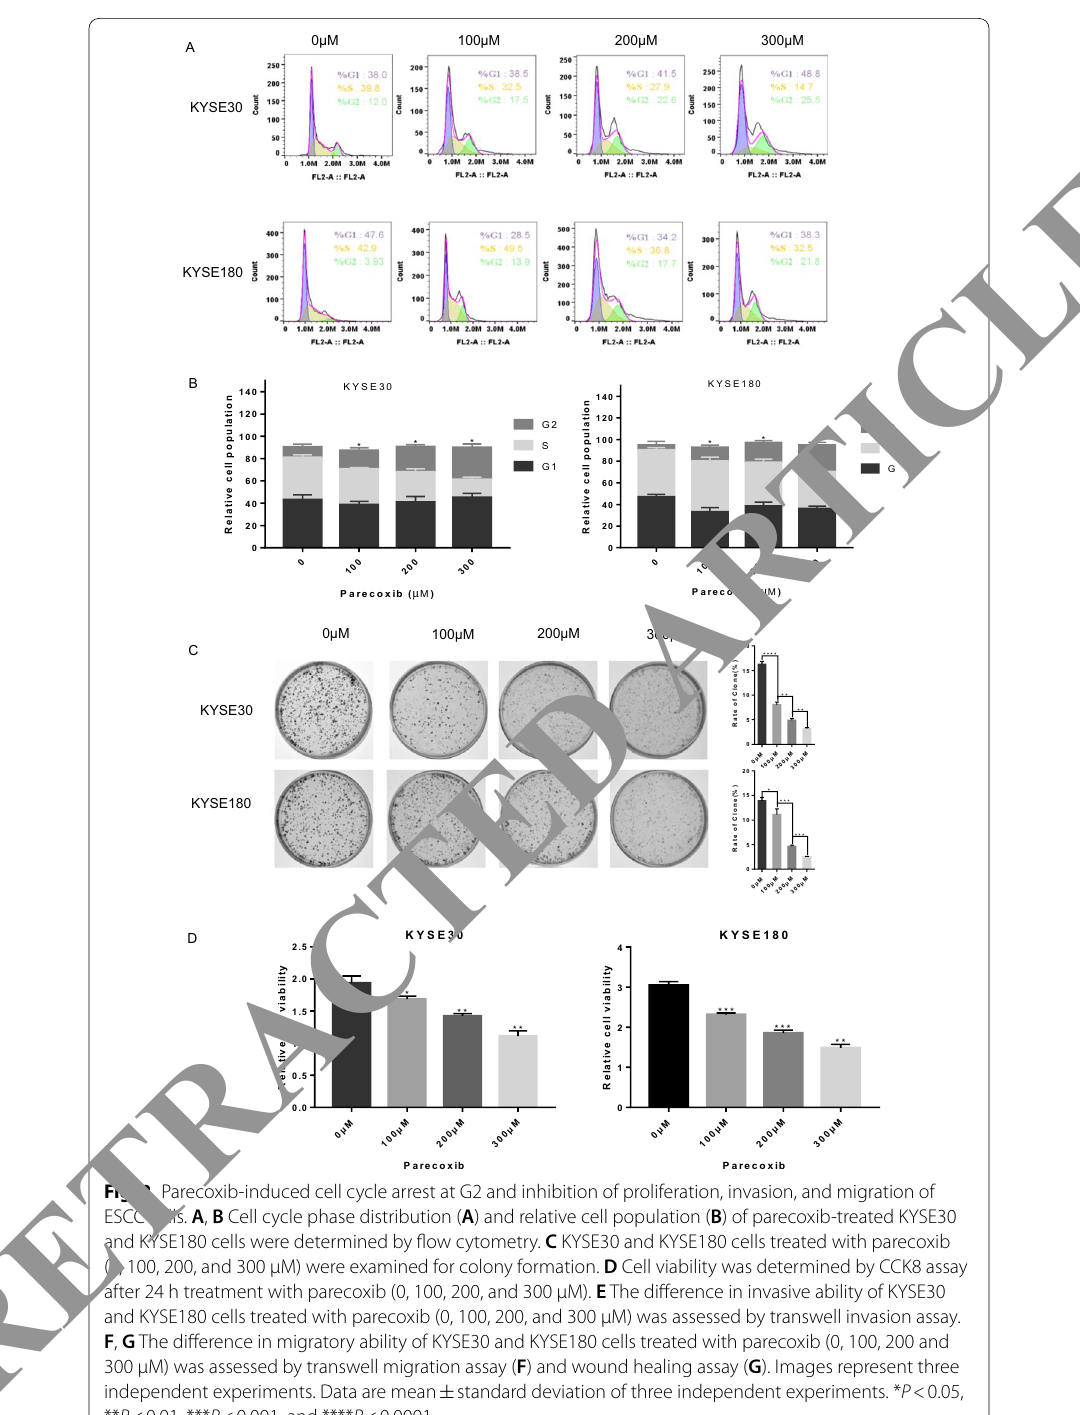
On the basis of the above results, we investigated whether parecoxib could reduce tumorigenicity in vivo. We injected 1.5 10 7 KYSE30 cells into right shoulder blade ×